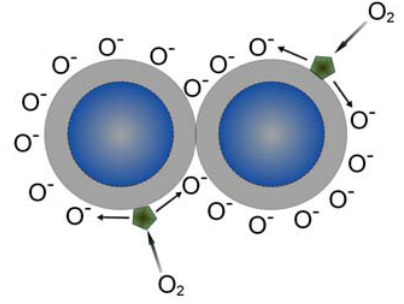
Figure 11. Oxygen spillover process in the surface of doped metal